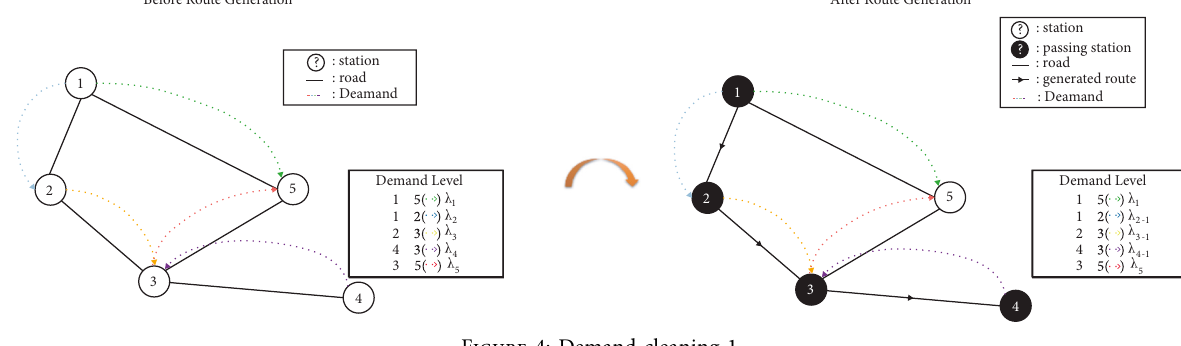
Figure 4: Demand cleaning